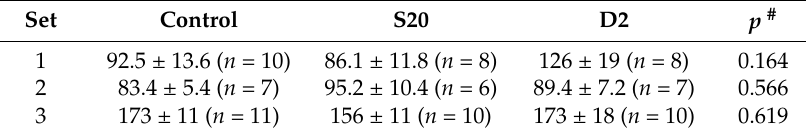
Table 1. Mean number of apoptotic events (±SEM) obtained in the control, S20 and D2 groups from 3 sets of experiments. n : numbers of embryos involved in the analyses. # p values obtained using ANOVA.